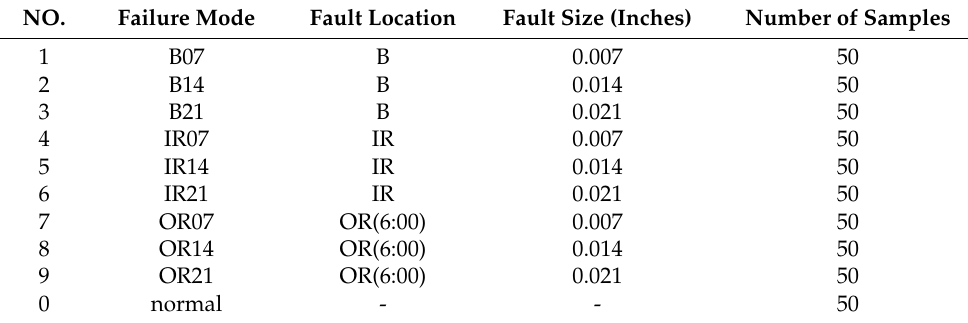
Table 4. CWRU bearing data.